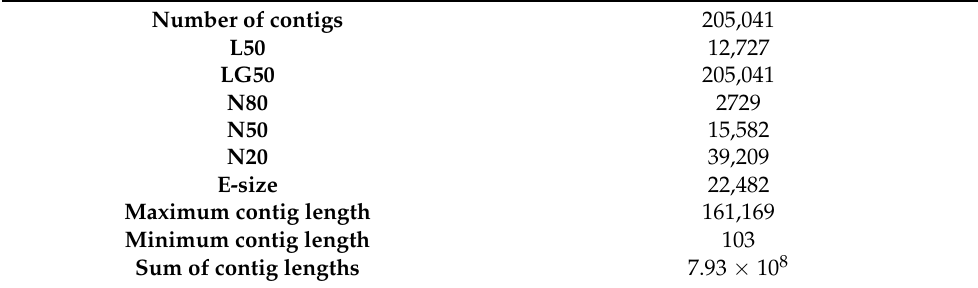
Table 1. Contiguity statistics. Standard metrics of assembly contiguity were generated using ABySS. Number of contigs